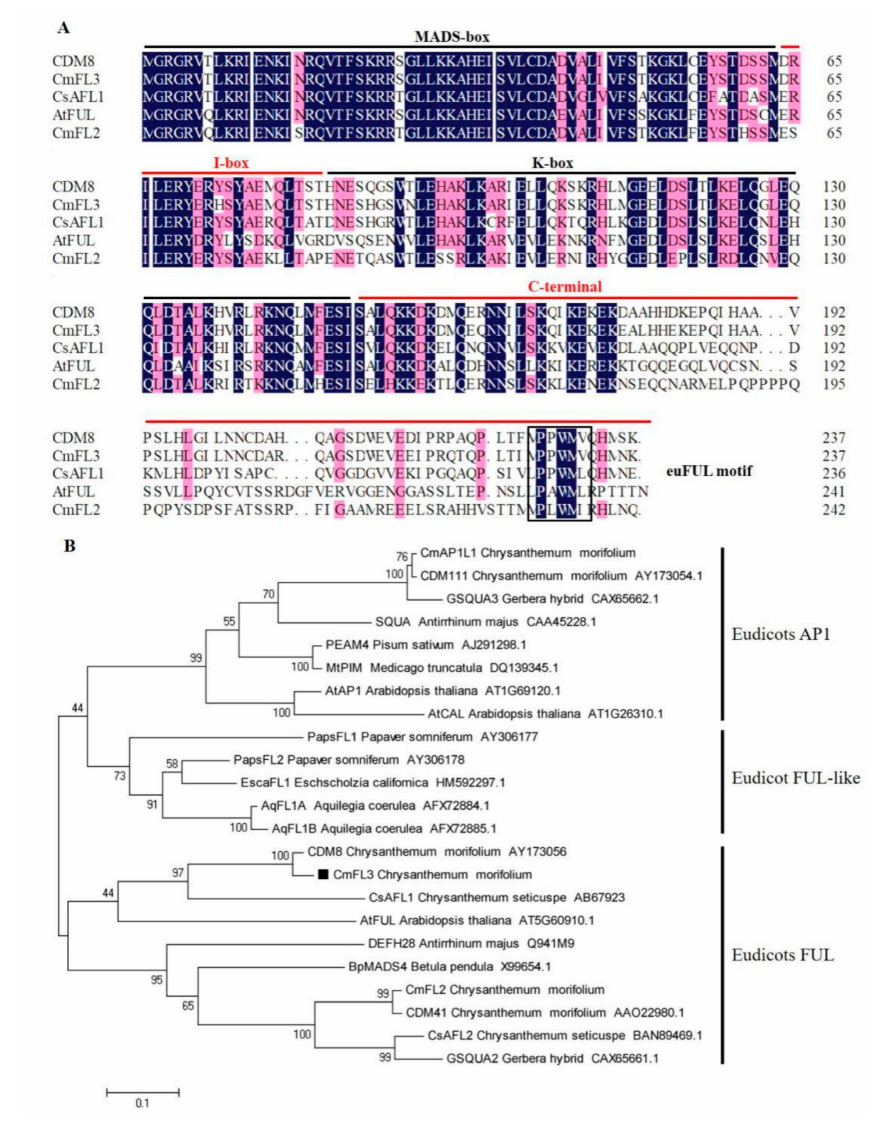
Figure 1. Sequence analysis of CmFL3. ( A ) Sequence alignment of CmFL3 and homologous proteins. The black color indicates 100% identity; red, 80% identity. Gaps are shown by dots; FUL motif is shown by the black box, and other key motifs are underlined. ( B ) Phylogenetic tree of AP1/FUL-like subfamily proteins and CmFL3 (black box). Detailed information is shown in the Supplementary Materials. The GenBank accession number of CmFL3 is